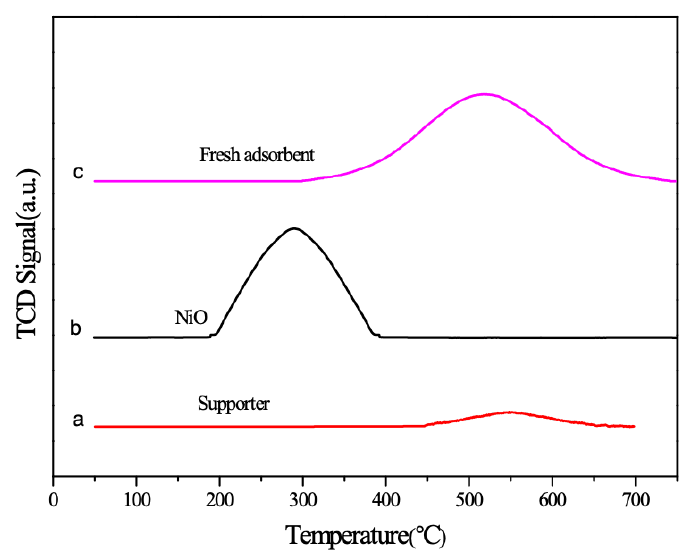
Figure 4. H 2 -TPR (temperature programmed reduction) of support (a), NiO (b) and fresh adsorbent (c).